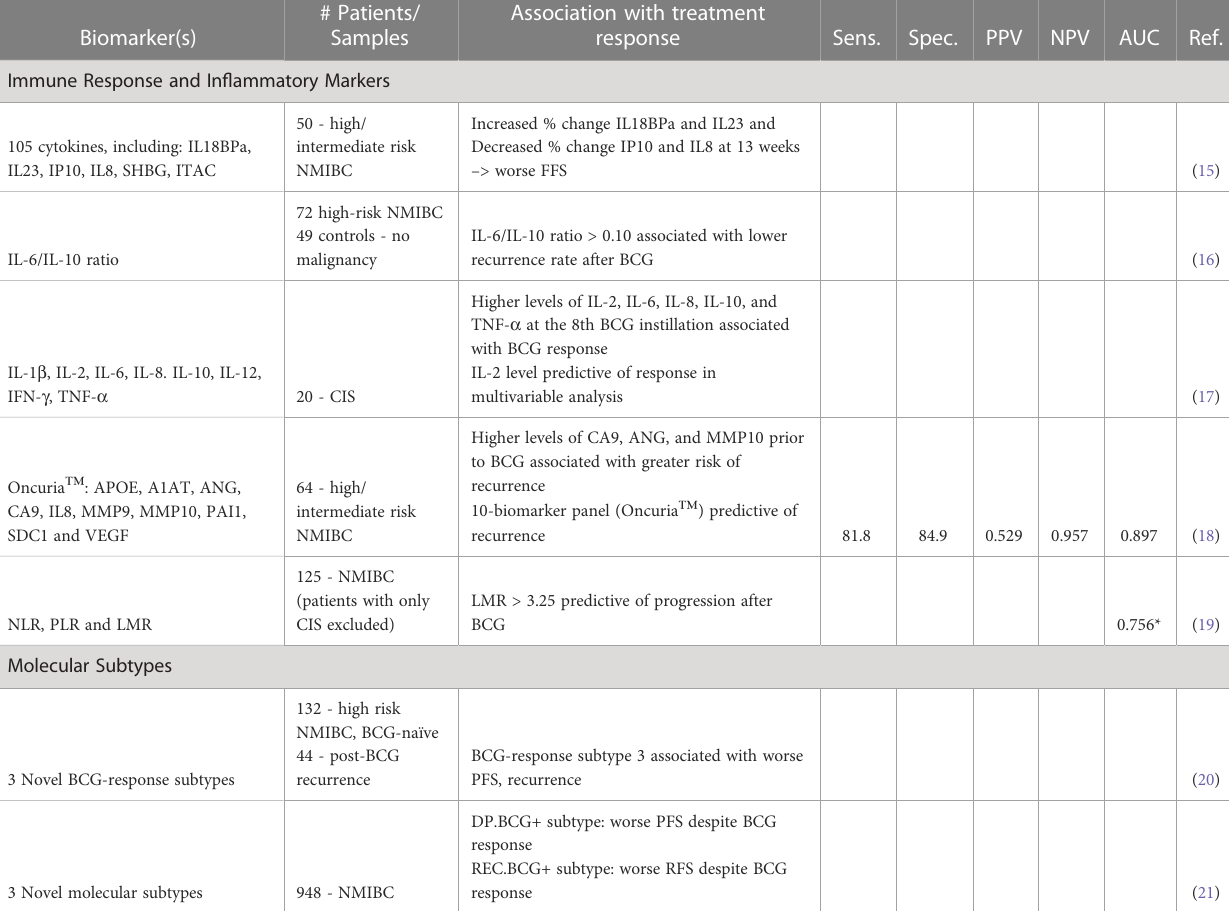
TABLE 1 Biomarkers predictive of outcomes after BCG